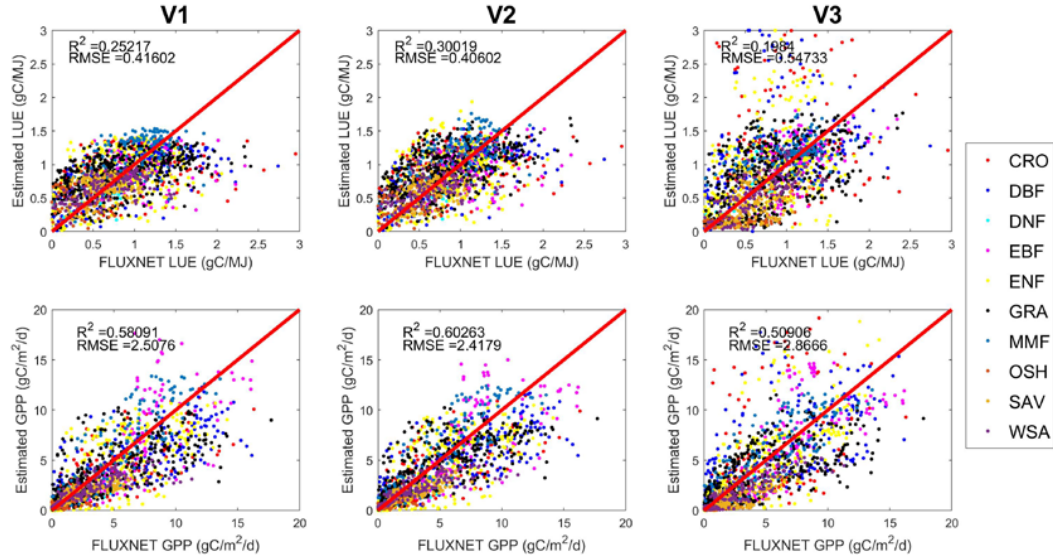
Figure4. LUEandGPP validation. V1: ParameterizationapproachwithouttheCI; V2: Parameterization Figure 4. LUE and GPP validation. V1: Parameterization approach without the CI; V2: 351 approach with the CI; V3: Cubist regression tree Parameterization approach with the CI; V3: Cubist regression tree approach. 352 Table 3. Light use efficiency (LUE) and gross primary productivity (GPP) validation for each type of 353 vegetation. 354